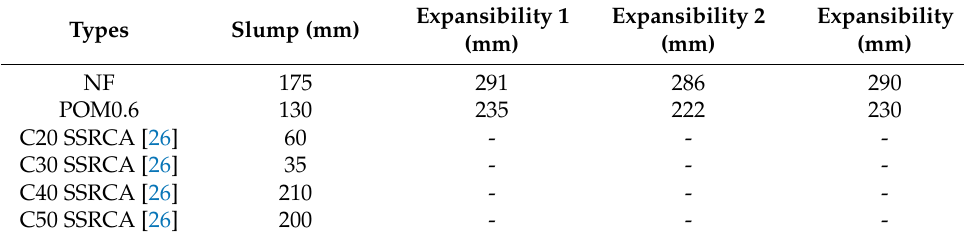
Figure 3. Expansibility test of SWSSC. Table 4. Workability of different types of